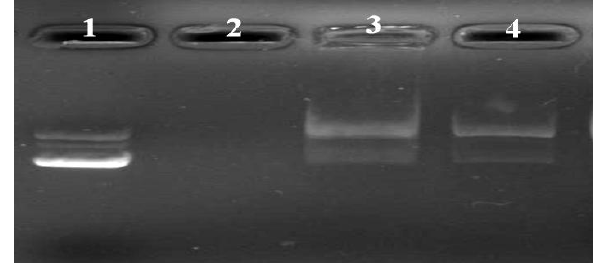
Figure 7. Agarose gel electrophoresis of PLA-PEG-PLL NPs/DNA complexes (N/P 15:1) after incubation with different concentrations of DNase I. Lane 1: Naked DNA; Lane 2: Naked DNA incubated with DNase I at 0.1 U/μg DNA for 30 min; Lane 3–4: NPs/DNA complexes incubated with DNase I at 0.1 and 0.2 U/μg DNA, respectively, for 30